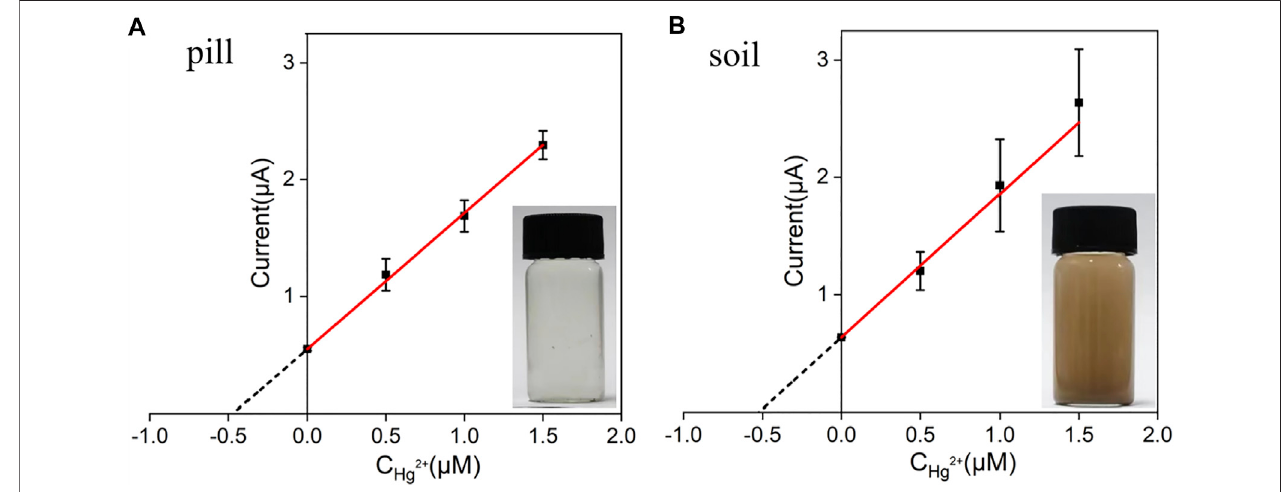
FIGURE 7 | The linear relationship between the anodic stripping currents and Hg 2+ concentration. Anodic stripping currents were measured by the VMSF/ITO electrode in bezoar antidotal pill (A) and soil (B) samples before and after the addition of a certain amount of Hg 2+ . The error bars represent the SD of three